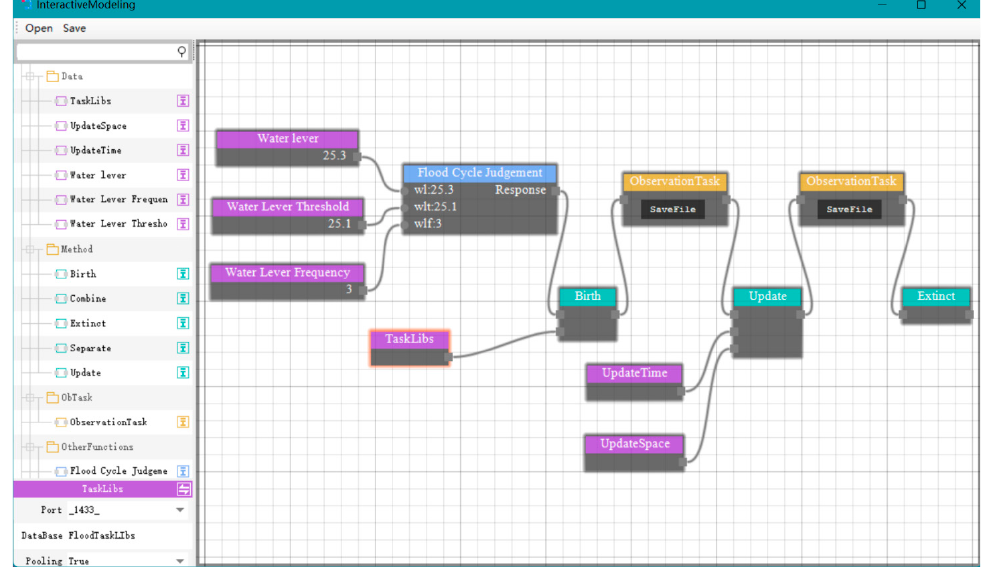
Figure 11. Drag-and-drop modeling visualization of the earth observation task process.